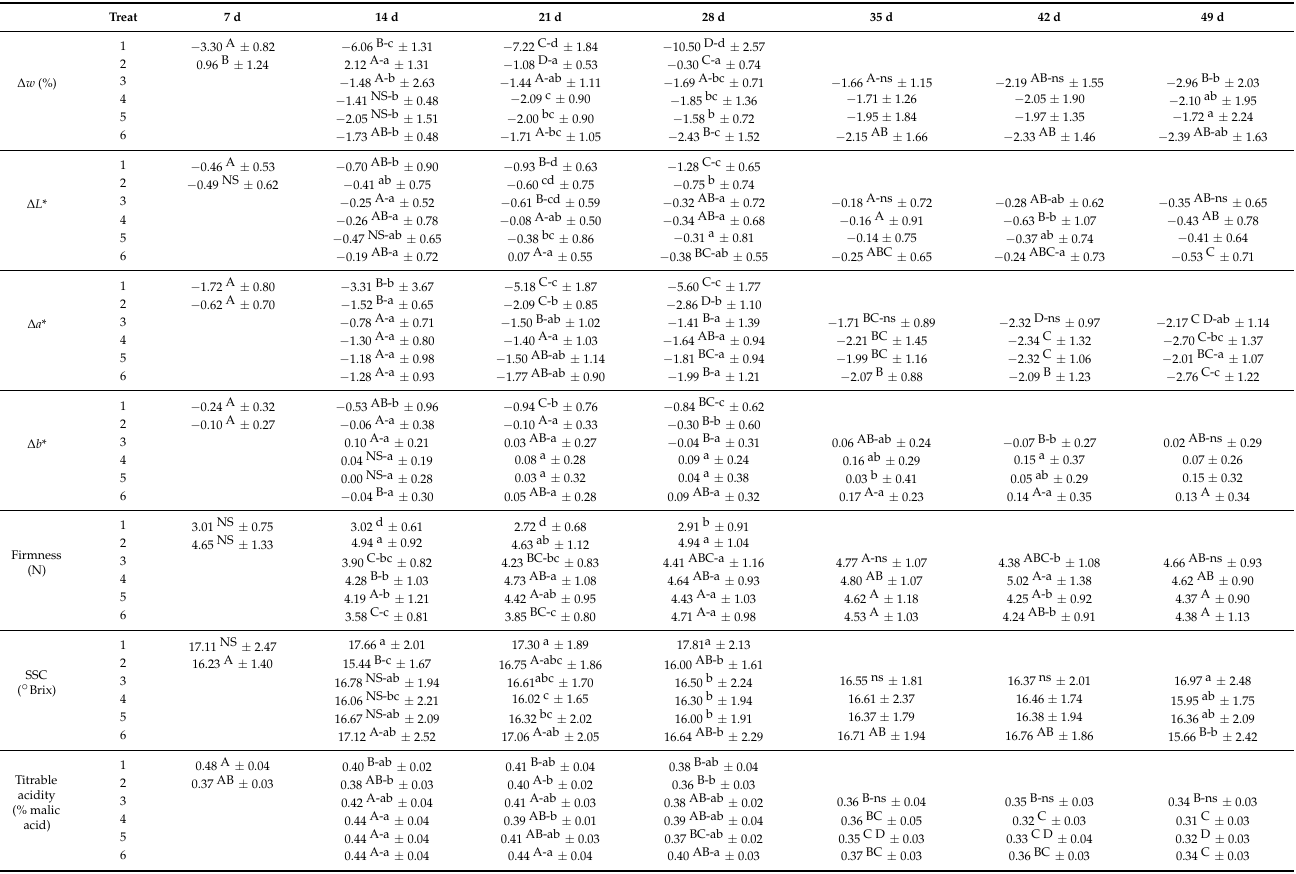
Table 5. Comparison of physicochemical variables between treatments and sampling days in 2020, evaluated in the sweet cherry cv. Satin conservation study. Treatment 1 was located at FO under normal atmosphere conditions. Treatments 2 to 6 were located at RC. Treatment 2 was under normal atmosphere conditions. The atmosphere composition of treatments 3 to 6 was,